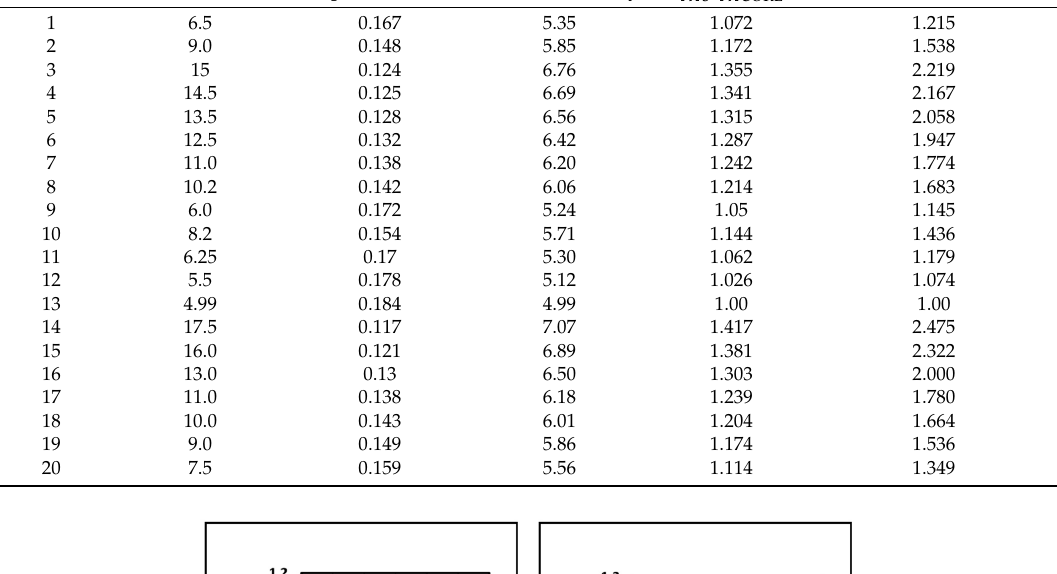
Table 2. Summary of virial coefficients, aspect ratios, intrinsic viscosities, [ η ] coefficients for twenty sets of asphaltene suspensions.